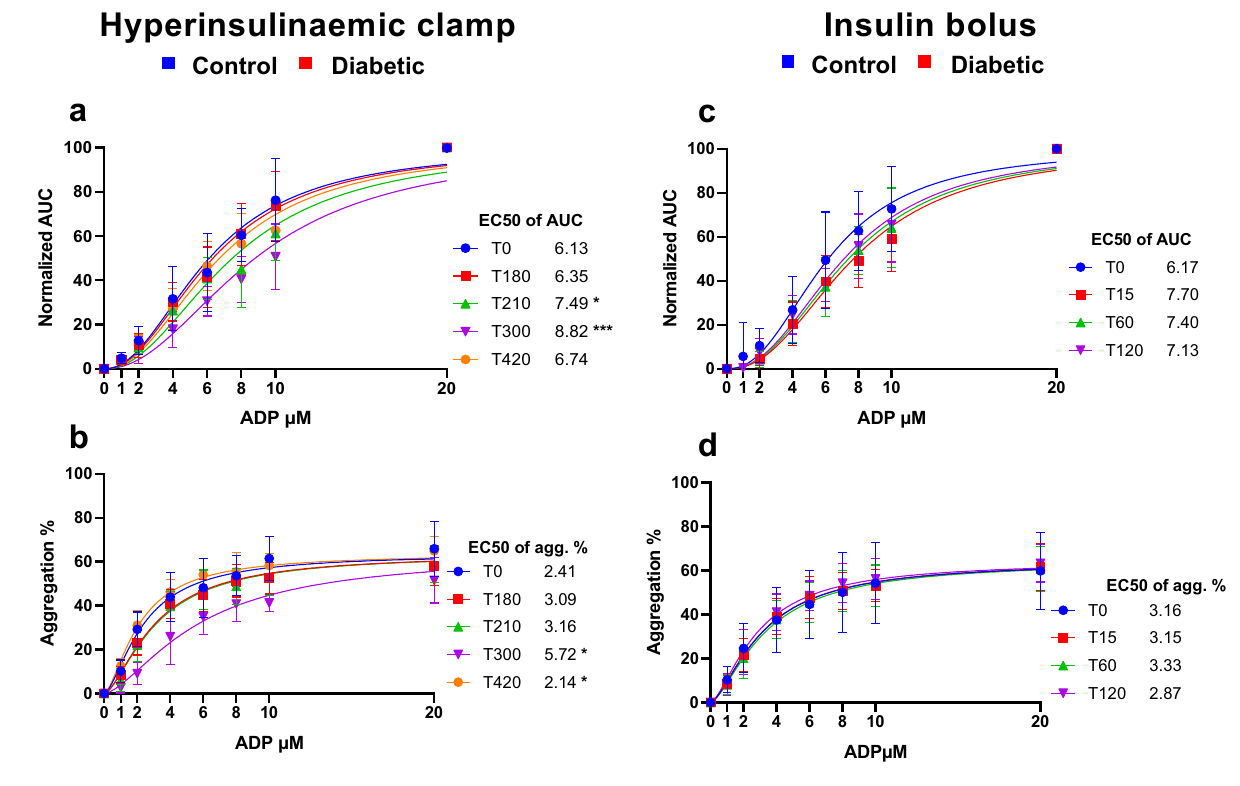
Figure 5. Platelet aggregometry. Light transmission platelet aggregometry, with no distinction between groups, at different time-points throughout the studies. Normalized (0–100%) area under the curve (AUC) at different concentrations of adenosine diphosphate (ADP) ( a + c ), and maximum aggregation percentage at different concentrations of ADP ( b + d ), both with overlays of fitted dose–response curves at the different time points. Hyperinsulinaemic clamp: blue line: time 0 representing baseline dose–response to ADP, red line: after 180 min representing two hours of normoglycaemia, green line: after 210 min representing 30 min of hypoglycaemia, purple line: after 300 min representing two hours of hypoglycaemia, orange line: 420 min representing two hours of normoglycaemia after hypoglycaemia. Data shown as medians ± interquartile range. Insulin bolus: blue line: time 0 representing baseline dose–response to ADP, red line: 15 min after insulin bolus, green line: 60 min after insulin bolus, purple line: 120 min after insulin bolus. Significant difference to baseline effective concentration for 50% reaction (EC50) labeled as stars (*) set to * P < .05 and *** P < .0001 by linear mixed modelling. Software used to generate graphs: GraphPad Prism 8 (GraphPad Software Inc., San Diego,